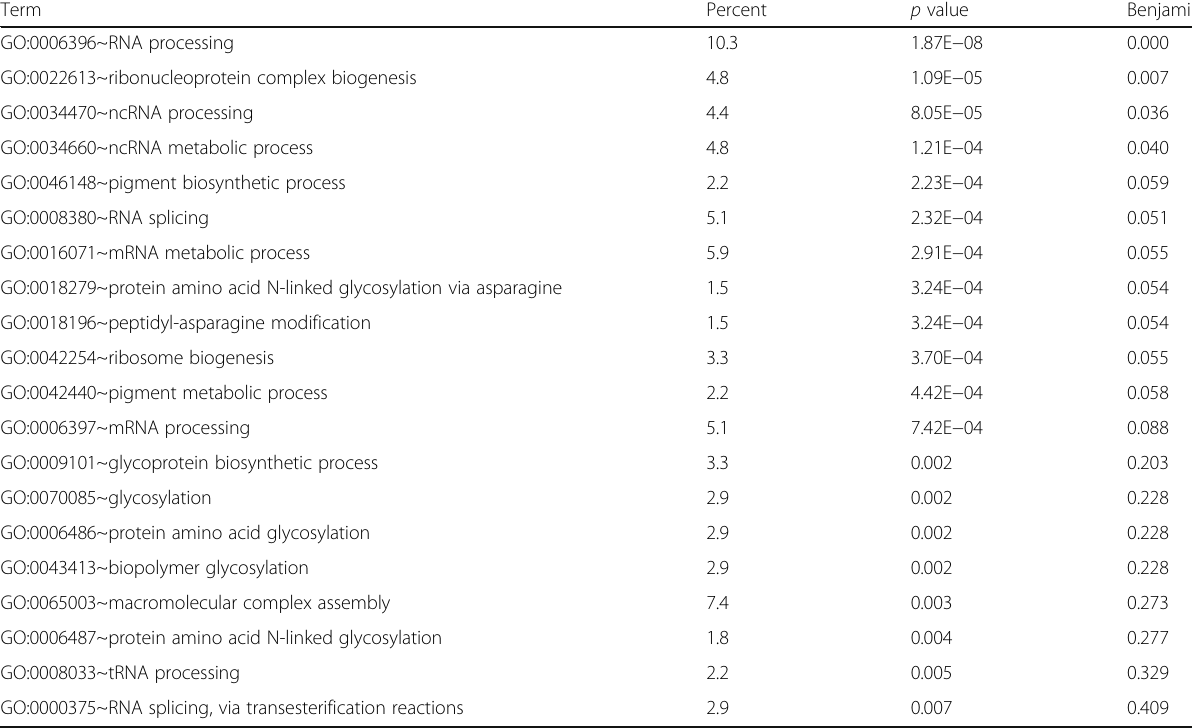
Table 4 Biological processes overrepresented in the genes with positive correlation with the SUV (from DAVID Bioinformatics Resources 6.7) Term Percent